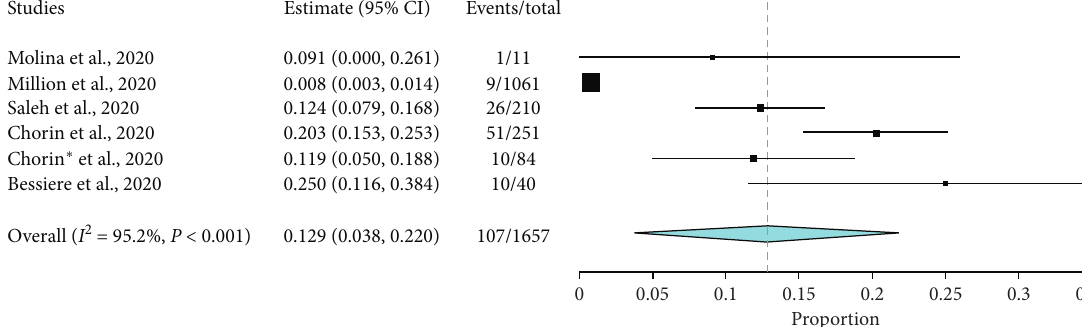
Figure 8: The proportion of COVD-19 patients with QTc increase by more than 60 ms from baseline after treatment with HCQ with or without